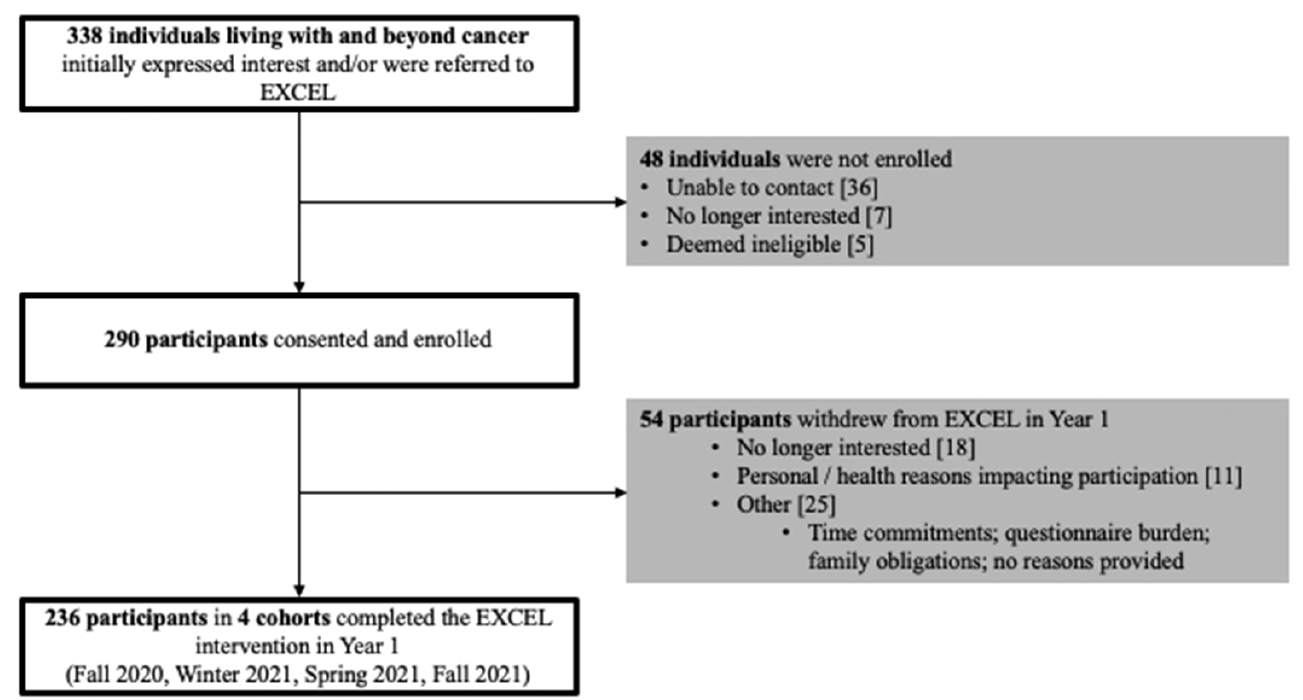
Figure 2. EXCEL first-year enrolment